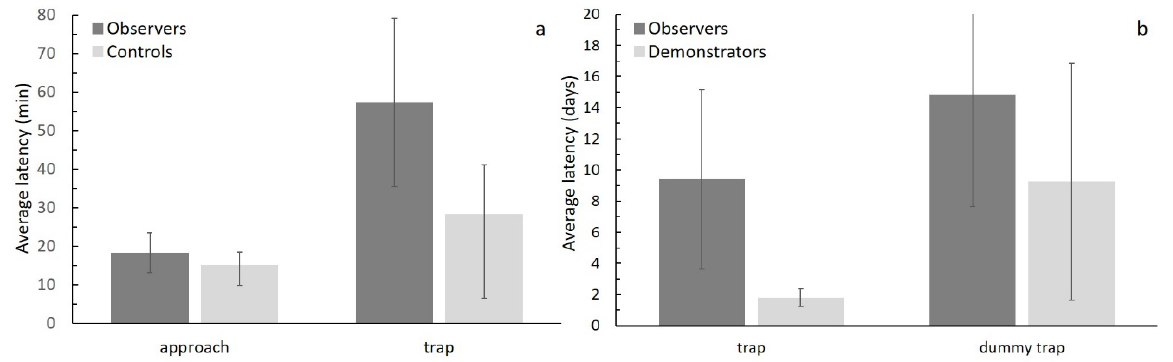
Average latency (in minutes or days ±SE) for captive coyotes to approach or get caught in a trap during Experiments 1 and 2.